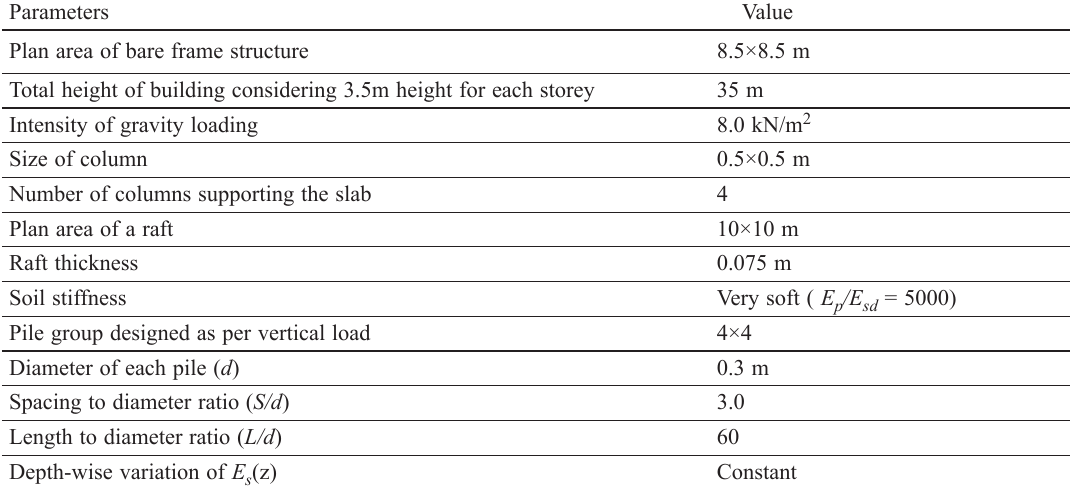
Table 8. Input parameters for example case study